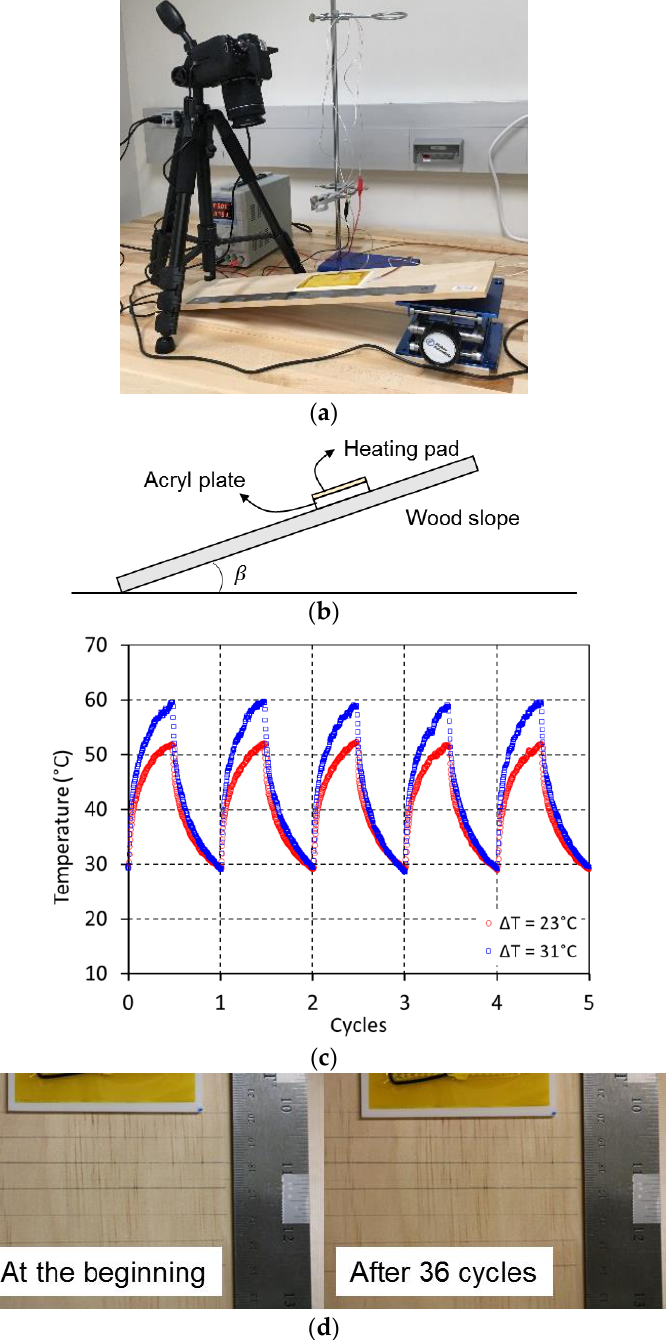
Figure 1. Experimental study of the thermally induced slip ratcheting. ( a ) Picture of the overall experimental setup, ( b ) schematic of the test design, ( c ) temperature fluctuation of the heating pad using a power supply and on-and-off switch, which results in the amplitudes of about 23 ℃ and 31 ℃ for 5 V and 6 V applied, respectively, and ( d ) an example of the slip ratcheting captured by the camera.